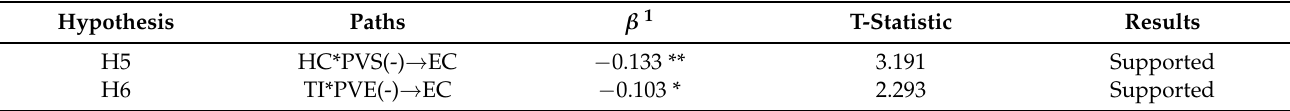
Table 6. Moderating effect test results of the research model.